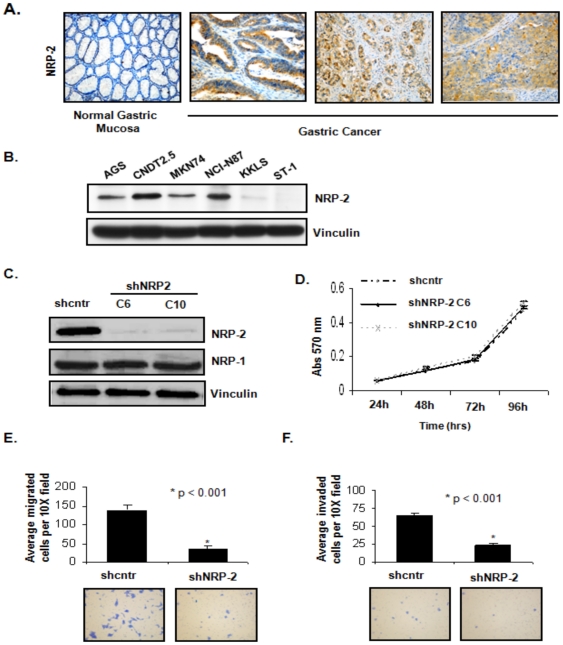
Assessment of NRP-2 expression in human gastric cancer tissues and cell lines.(A) Immunohistochemical staining for NRP-2 expression in representative tissue sections (20X) of normal human gastric mucosa and gastric cancer specimens (B) Immunoblot analysis of NRP-2 expression in six human GI cancer cell lines. Vinculin served as an internal loading control. (C) Generation of stable CNDT 2.5 cell lines with NRP-2 knockdown. Immunoblot analysis of NRP-1 and -2 expression in CNDT 2.5 cells transfected with shcntr or shNRP-2 plasmids (shNRP-2 clones; C6 and C10). Vinculin served as a loading control. (D) MTT assay results. Growth rates were no different between the control cells and NRP-2 knockdown clones. Bars indicate SEM. (E) Top: Mean number of cells that migrated in a Boyden chamber assay. Bottom: Representative images (10X) of migration assays. (F) Top: Mean number of cells that invaded in BioCoat Matrigel invasion chamber assay. Bottom: Representative images (10X) of invasion assays.